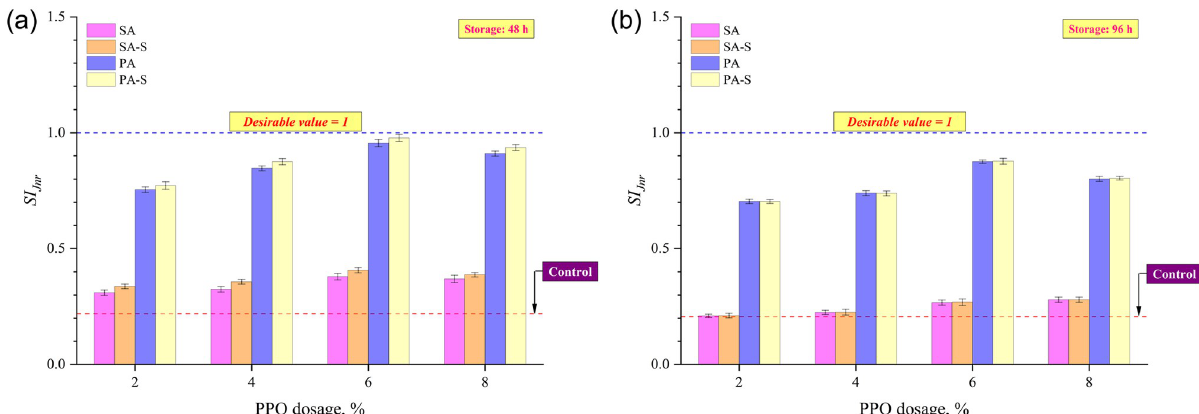
Fig 8. SI based on MSCR J nr after (a) 48 h and (b) 96 h of thermal storage.